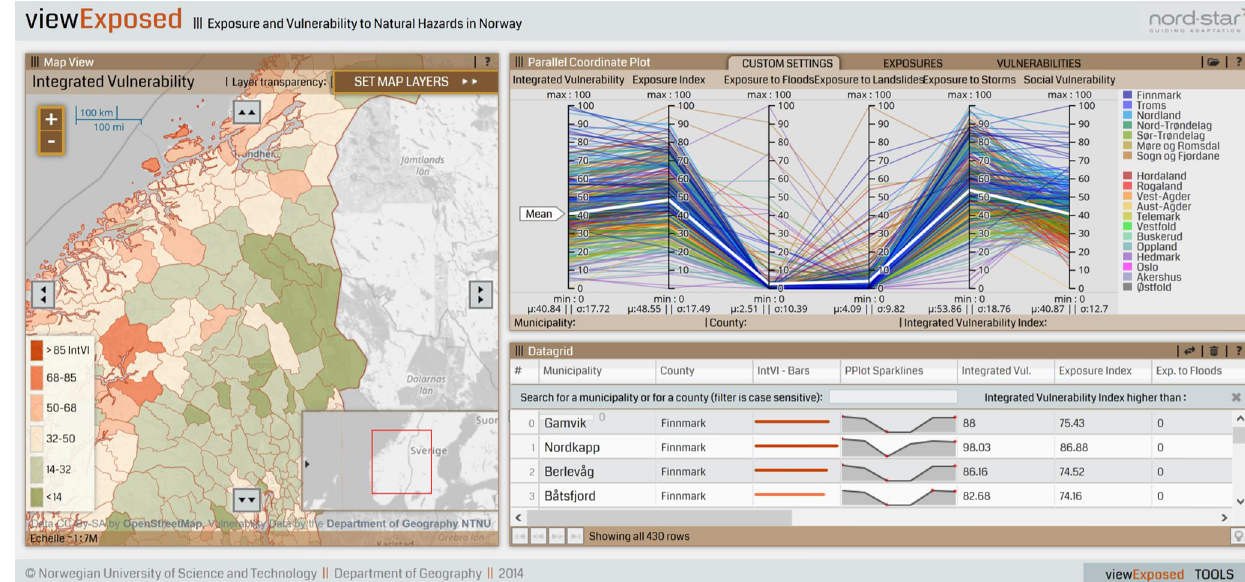
Figure 5. The ViewExposed interface (Opach and Rød,